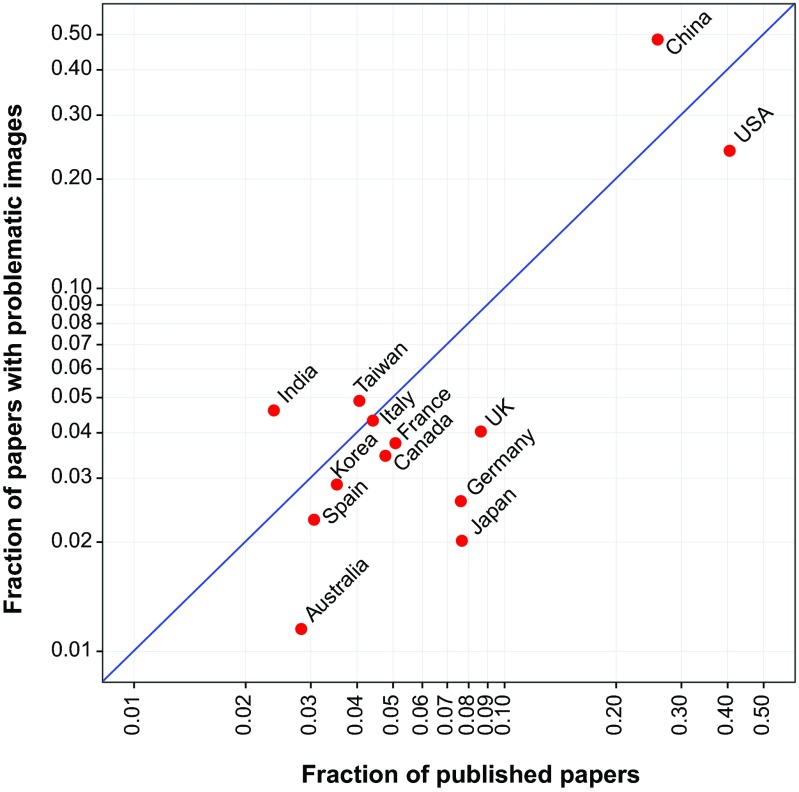
Proportion of papers with image duplications by country. The proportion of papers affiliated with specific countries submitted to PLoS One during a 16-month period in the years 2013 and 2014 (n = 8,138) plotted versus the proportion of PLoS One papers from that same period containing inappropriate image duplication, affiliated with specific countries (n = 348). Each data point represents a country for which 100 or more papers were screened. Some papers were affiliated with more than one country. The blue line represents where data points are expected to fall if problematic papers are distributed as expected according to their representation in the journal. Countries plotted above the blue line had a higher-than-expected proportion of problematic papers; countries plotted below the line had a lower-than-expected ratio.